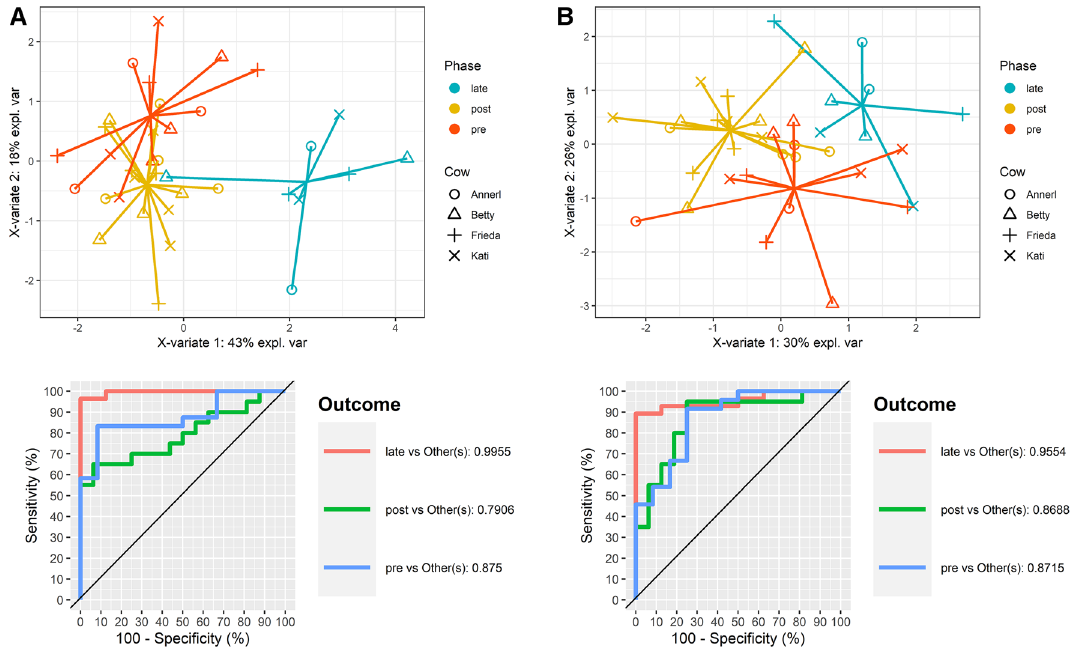
Figure 8. Supervised Clustering of the results of Bovela treatment (group C), three components with only the most promising features. ( A ) PLS-DA using blood parameters (AUROC: “pre” vs others: 0.875, “post” vs others: 0.791, “late” vs others: 0.996); ( B ) PLS-DA using milk parameters (AUROC: “pre” vs others: 0.872, “post” vs others: 0.869, “late” vs others: